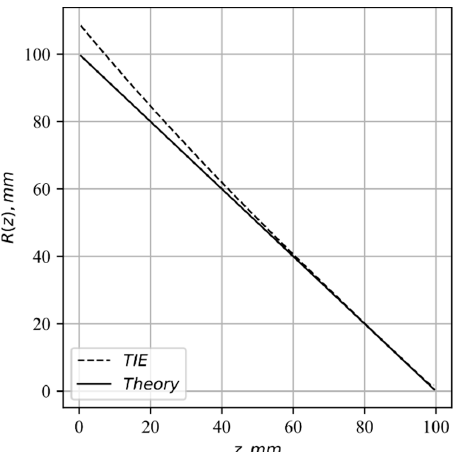
Figure 5. Dependence of the error in determining RoC of the wavefront on the R 0 = 100 mm; z = 0, ∂ z , 2 ∂ z , …, R 0 ; ∂ z = 1 mm.